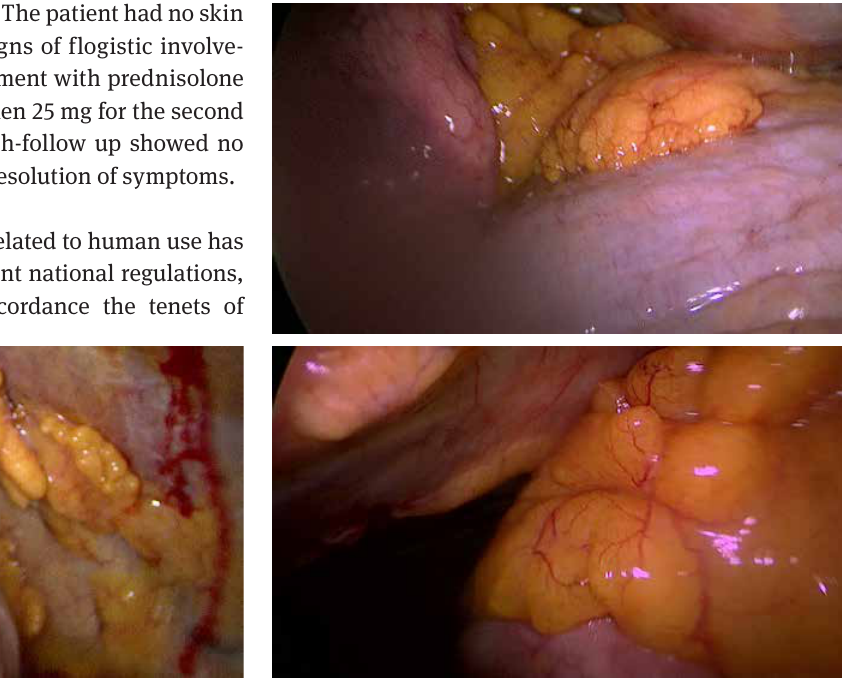
Figures 1-3: Images of the parietal pleura which appeared covered, on the whole surface, by islands of adipose tissue, without macroscopic pathological